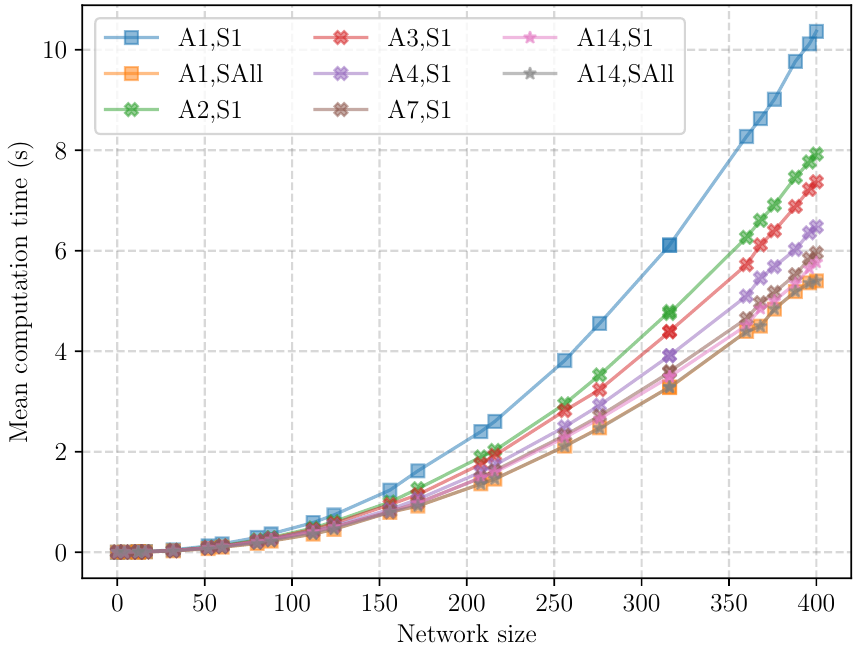
Figure 32. Mean schedule computation time for different network sizes and scenarios using up to 8 channels, aggregation, and either a single sink or all anchors as